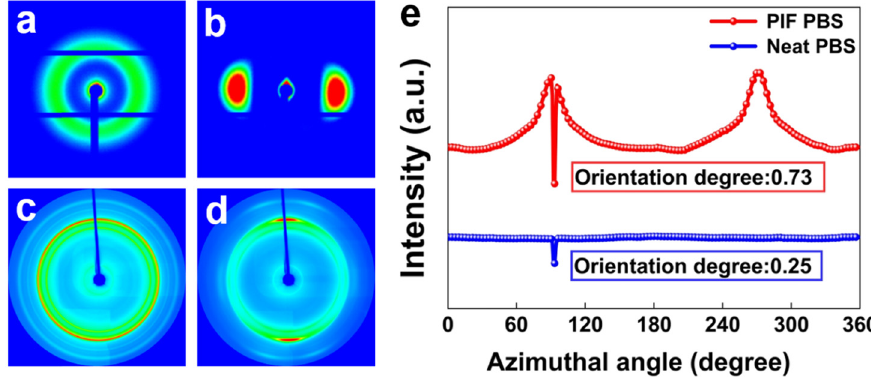
Figure 3: 2D - SAXS patterns of ( a ) neat PBS and ( b ) PIF PBS; 2D - WAXD patterns of ( c ) neat PBS and ( d ) PIF PBS; ( e ) the 1D - WAXD curves of neat PBS and PIF